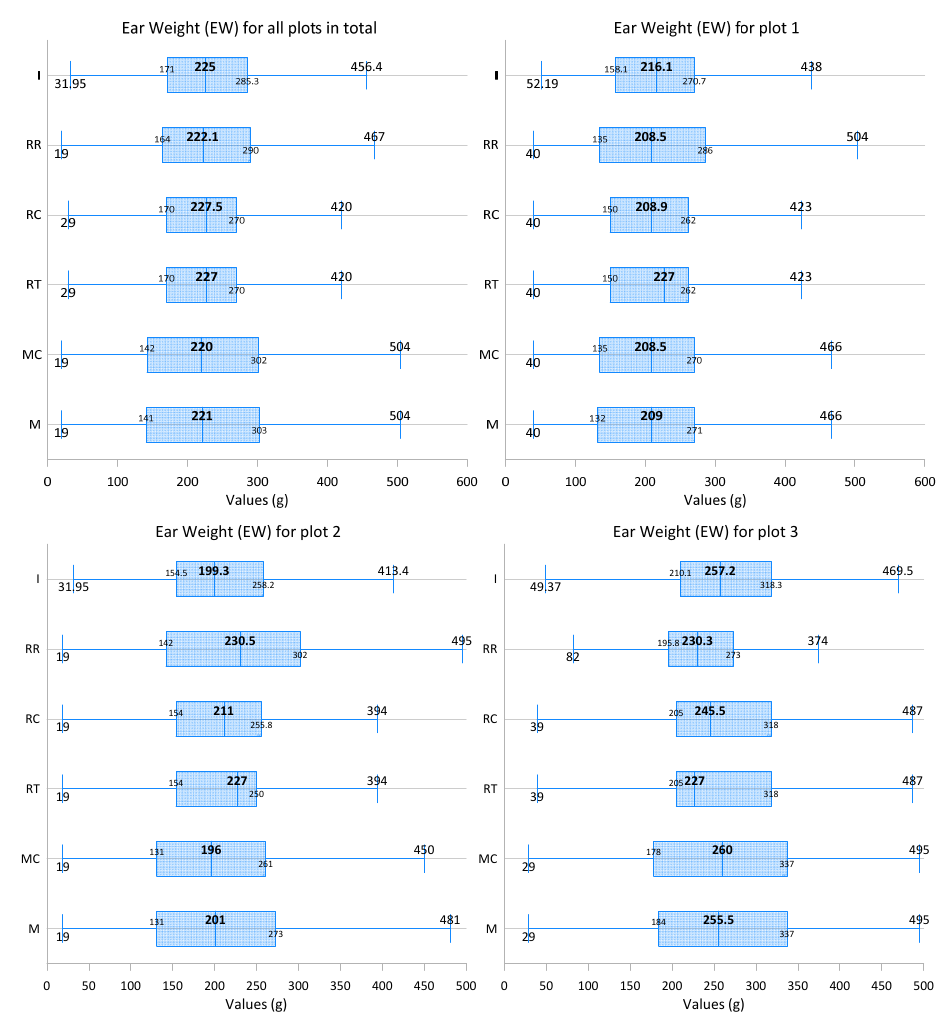
Figure 5. Dry weight (DW) descriptive statistics for the different sampling methods: M: Measured (all data); MC: Measured cut (without the measurements from the upper part area—lines 20 to 25); RT: Missing values were replaced by the total average of all values; RC: Missing values were re- placed by the average of the column, where the missing value belongs to; RR: Missing values were replaced by the average of the row, where the missing value belongs to; I: Interpolation.